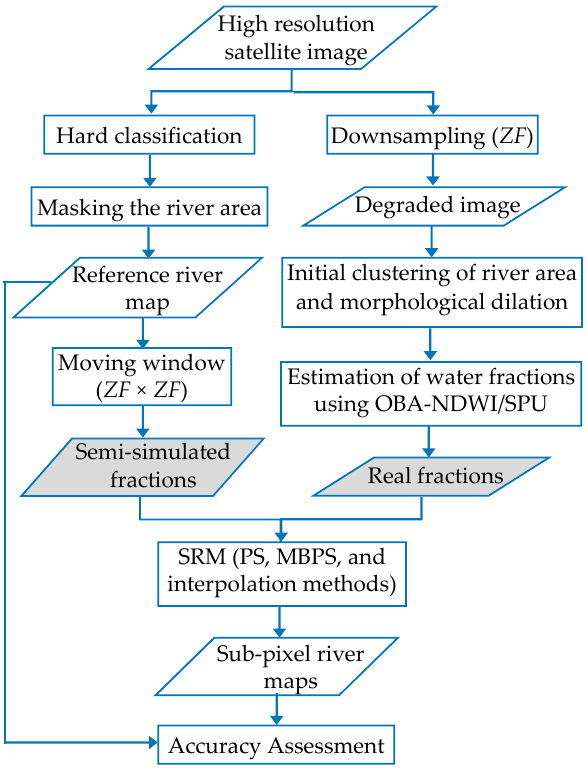
Figure 2. The procedure considered for the mapping and assessment of river boundaries at the sub-pixel resolution using both real and semi-simulated fractions; ZF represents the zoom factor.